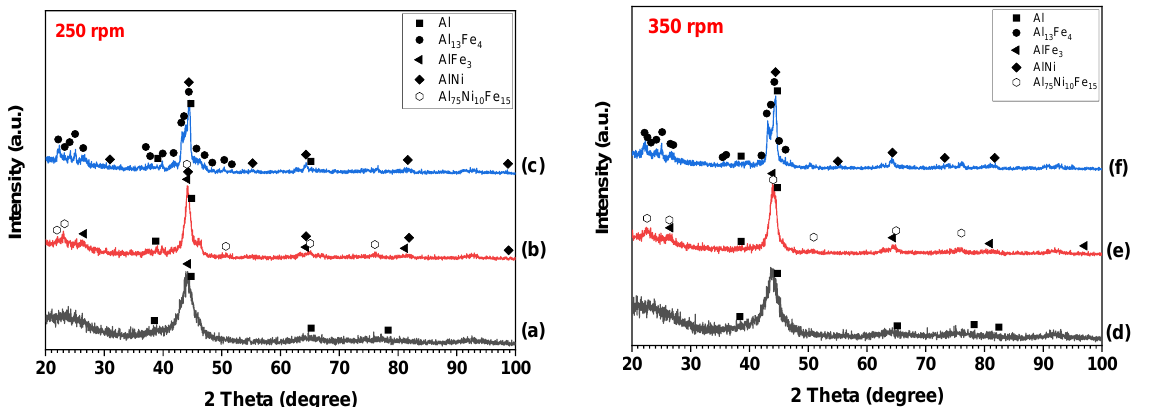
Figure 7. XRD patterns of Al 82 Fe 14 Ni 4 amorphous alloys after heat treatment at (a,d) 480, (b,e) 600 and (c,f) 700 °C.